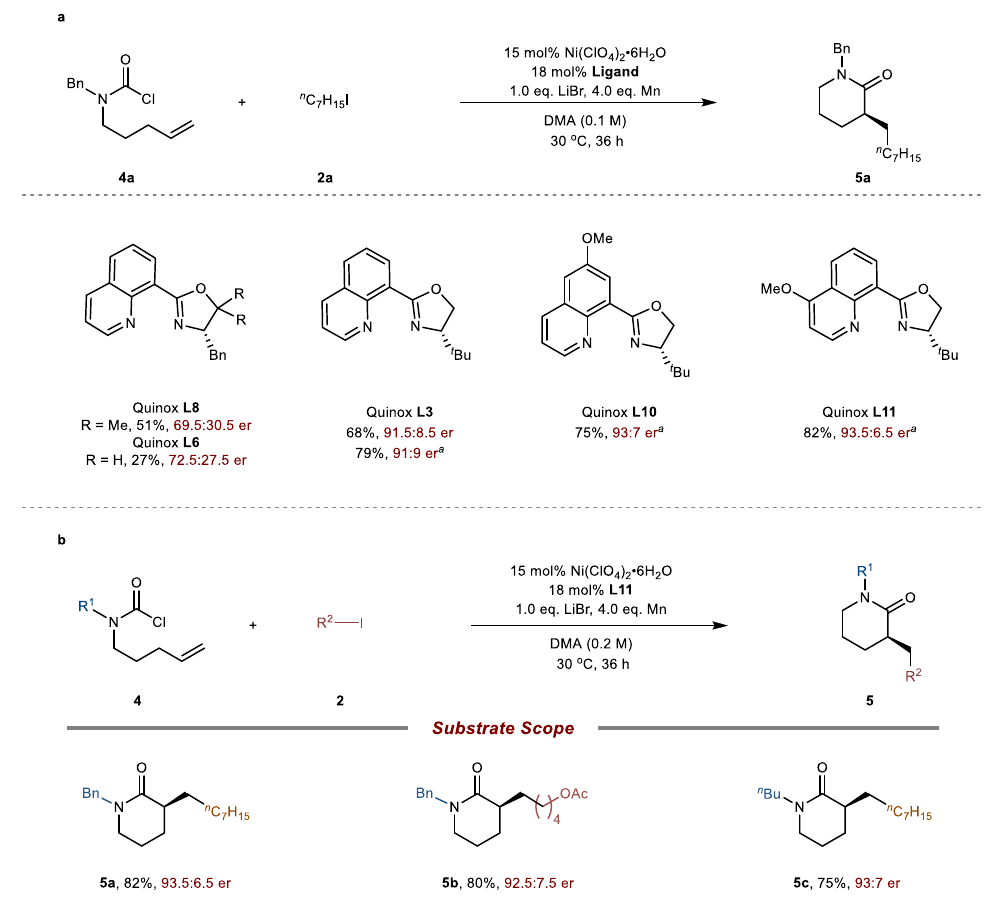
DMA(0.1M),stirredfor36hunder30°C.TheyieldswerereportedascorrectedGC yieldandtheervaluesweredeterminedbyHPLCanalysis; a 0.2M. b Substratescope for δ -lactam